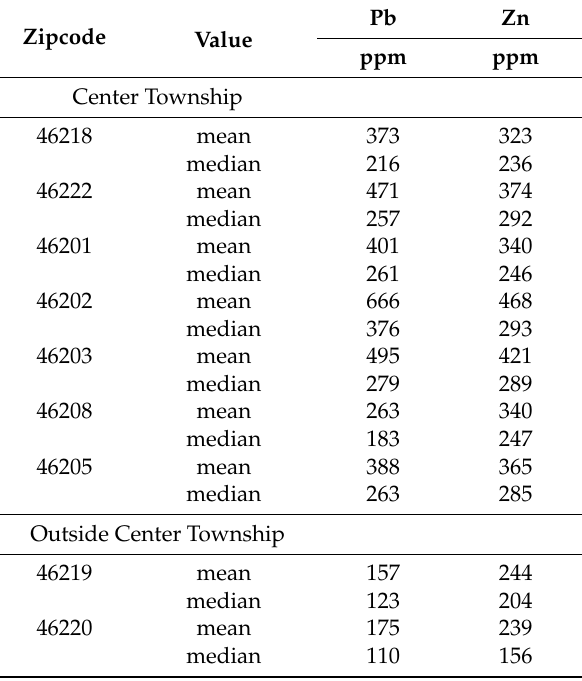
Table 2. Concentration of yard soil Pb and Zn sorted by Zipcode (only where over 20 samples were tested). Indianapolis, Indiana. Center township represents the downtown and near downtown